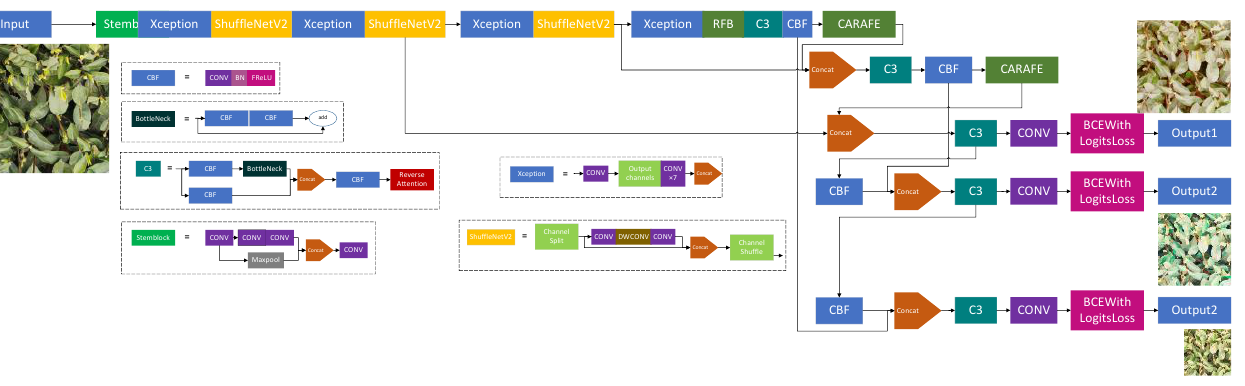
Figure 11. Improved YOLOv5 network structure.